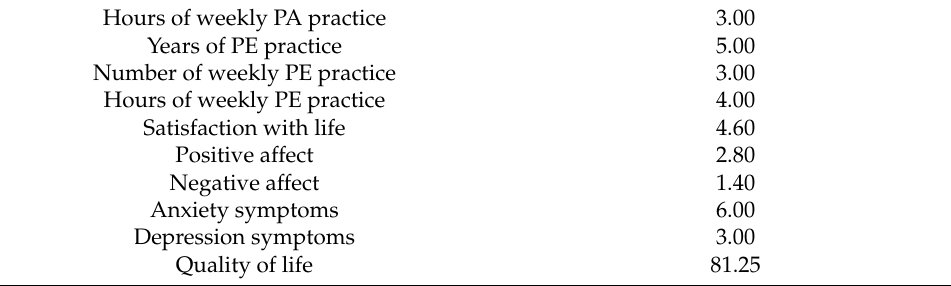
Table 1. Summary of the descriptive